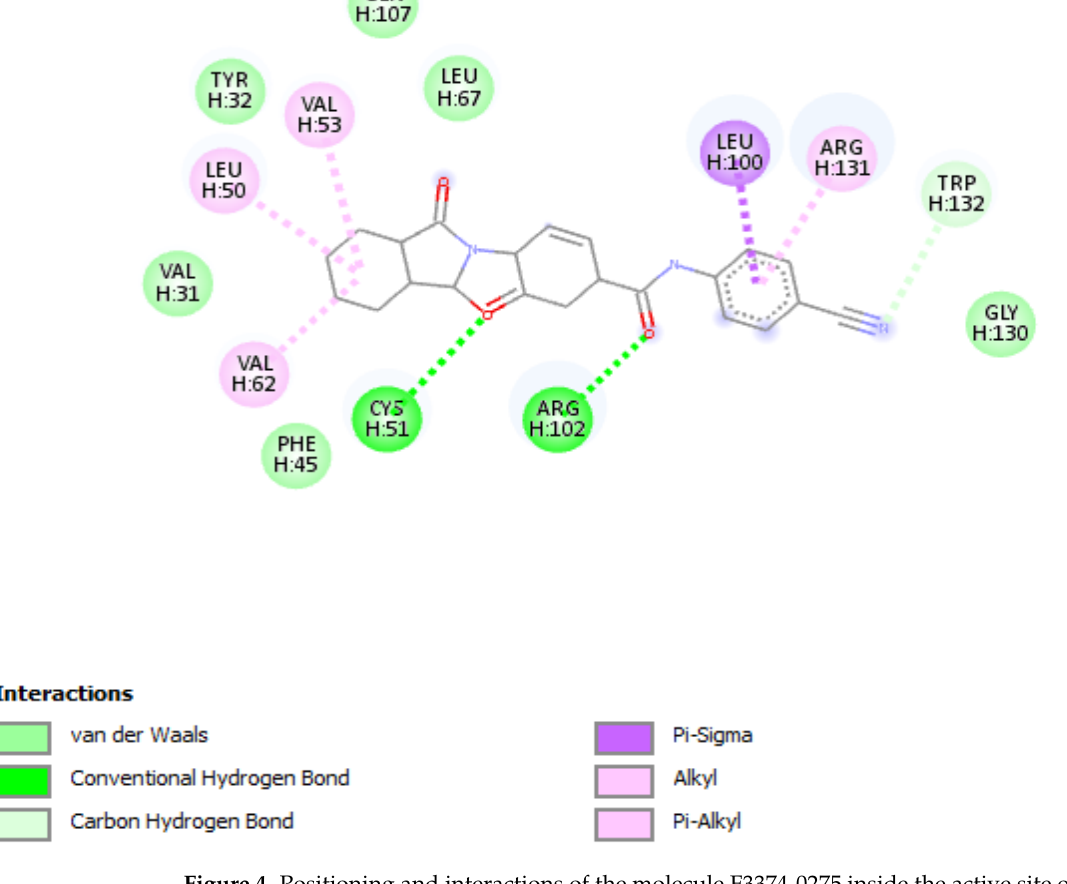
Table 2. Analysis of the pharmacokinetic properties and toxicity of the three candidate molecules. Compound Name